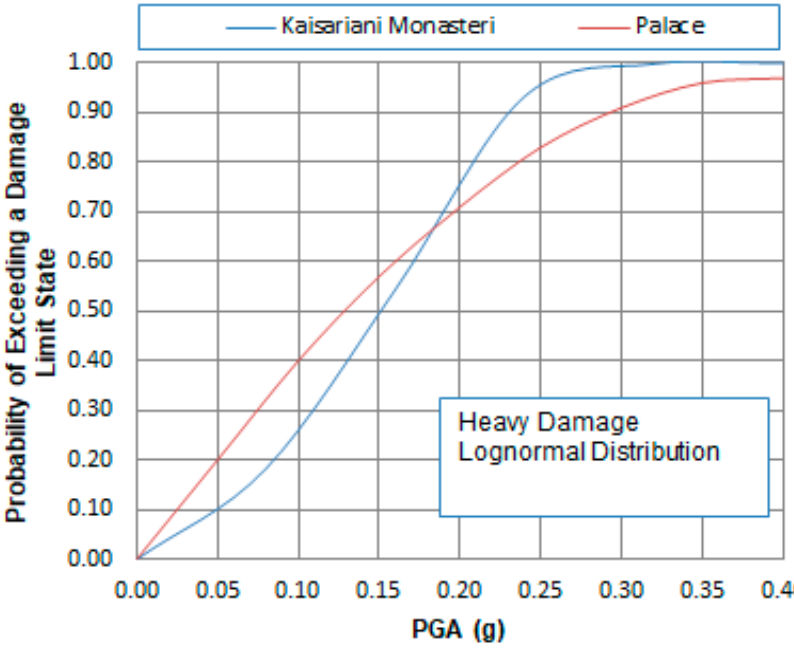
Figure 48. Fragility Curves of the current condition for two real case monumental structures using lognormal distribution.